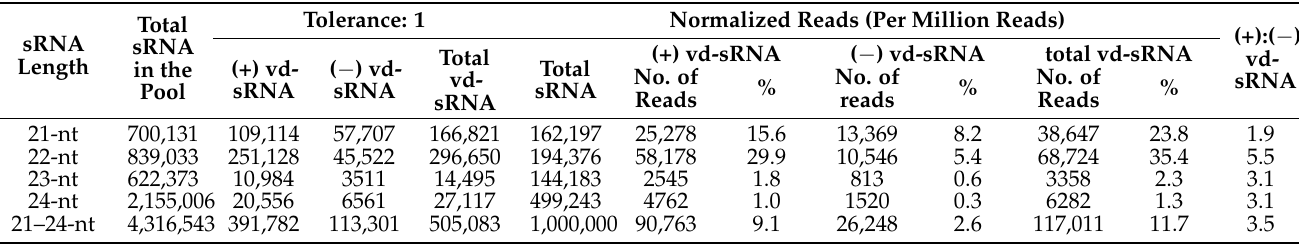
Table 3. Summary of the sRNAs identified by NGS from PSTVd-I-inoculated tomato plants cv. Rutgers at one mismatch with the PSTVd-I